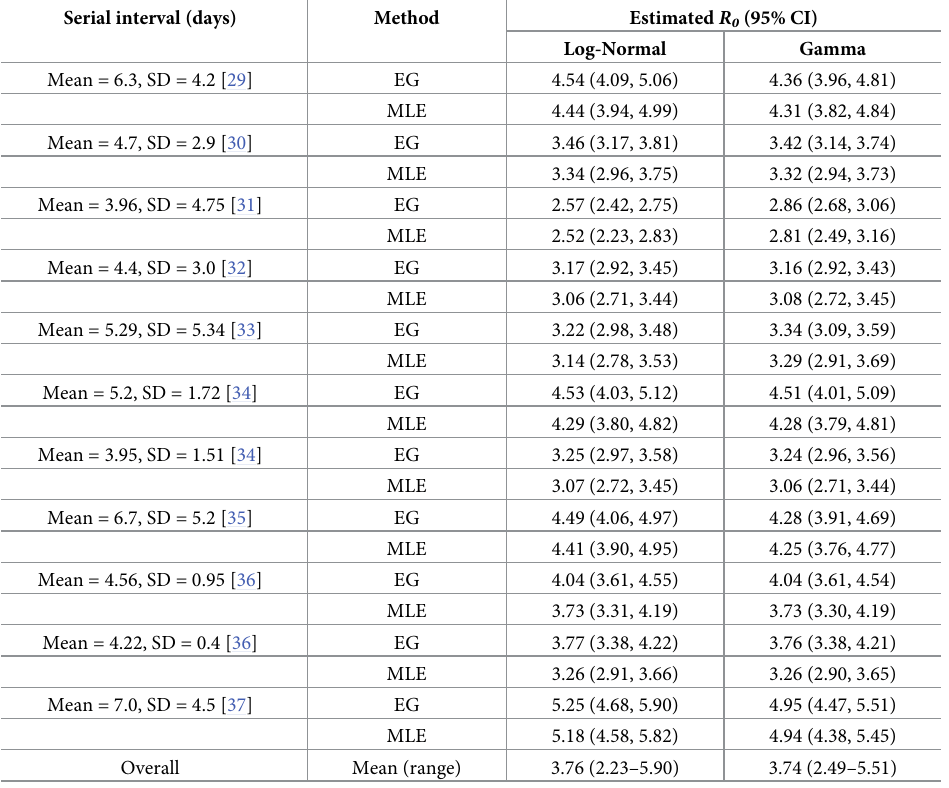
Table 1. Estimates of R 0 for COVID-19 in Thailand using exponential growth rate (EG) and maximum likelihood (MLE) methods with two different distributional assumptions (Log-Normal and Gamma) of serial